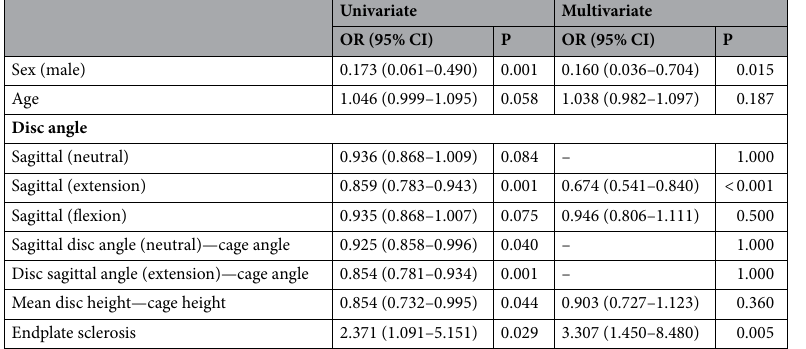
Table 5. Risk factor analysis for intraoperative endplate injury (IEPI). Logistic regression analysis was